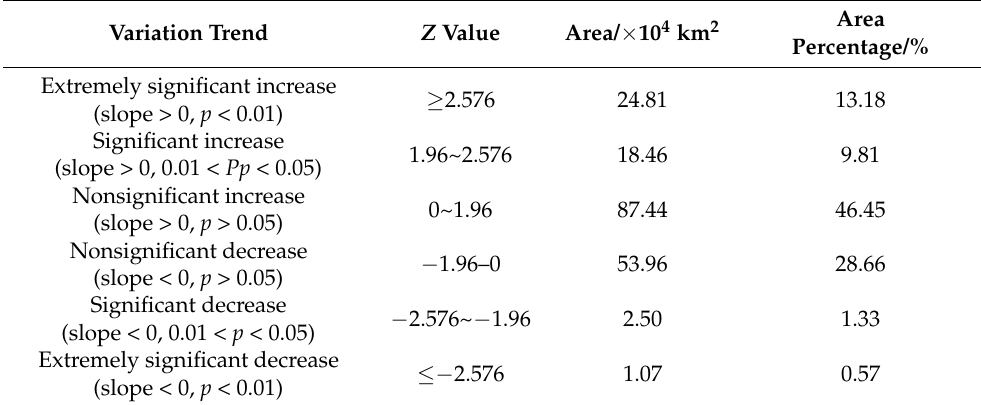
Table 2. Statistics on the variation trend in the NDVI during the growing seasons in the VQTP from 2000 to 2018.